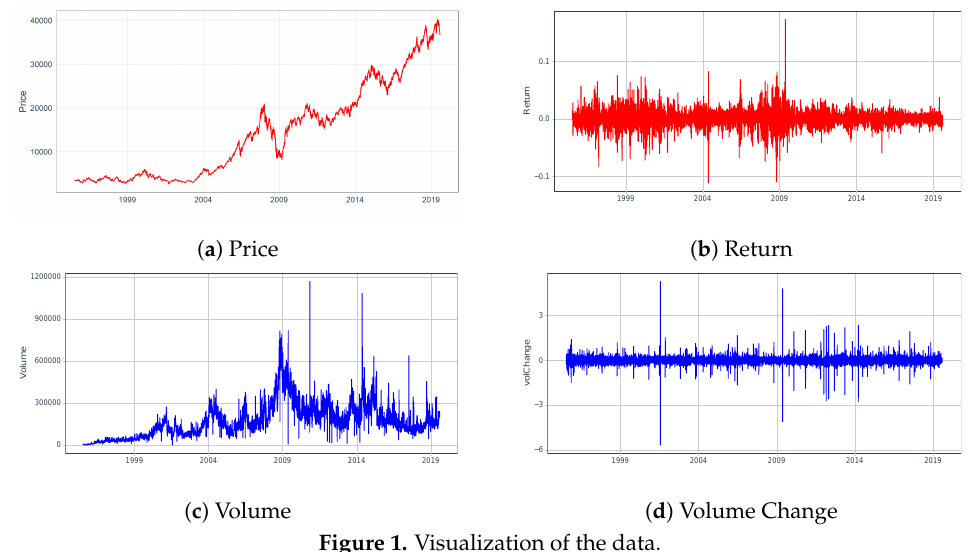
Figure 1. Visualization of the